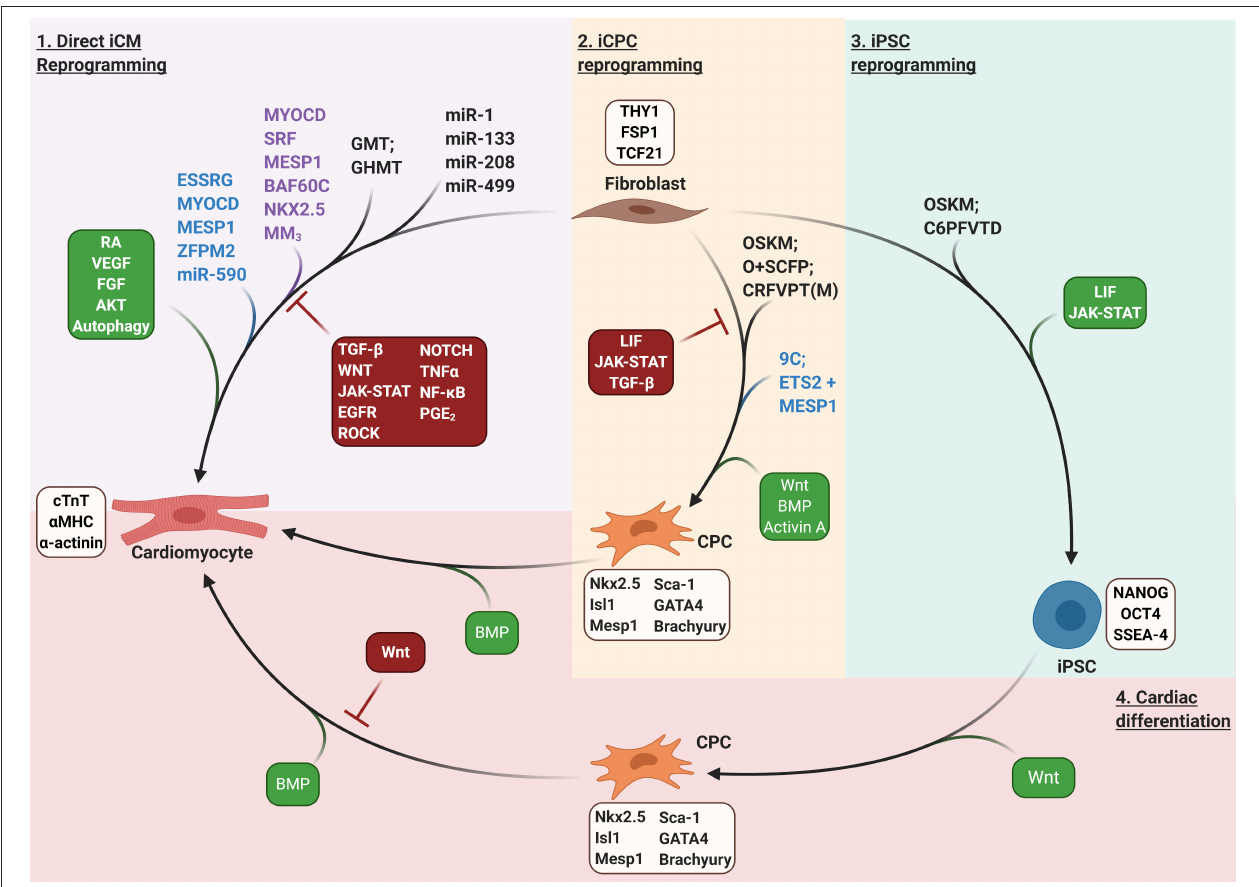
FIGURE 2 | Fibroblast reprogramming strategies. Purple shaded region: direct iCM reprogramming. GMT/GHMT, G ATA4, M EF2C, T BX5/ G ATA4, H AND2, M EF2C, T BX5; MM 3 , MYOD transactivation domain—MEF2C fusion protein. Tan shaded region: iCPC reprogramming; OSKM, O CT4, S OX2, K LF4, C- M YC; O + SCFP, O CT4 + S B431542, C HIR99021, F orskolin, and P arnate; CRFVPT(M), C HIR99021, R epSox, F orskolin, V alproic acid, P arnate, T TNPB, and (Rolipra m ); 9C; CHIR99021, BIX01294, A-83-01, AS8351, SC1, OAC2, Y27632, SU16F, and JNJ10198409. Green shaded region: iPSC reprogramming. C6PFVTD; C HIR99021, 6 16452, P arnate, F orskolin, V alproic Acid, T TNPB, and D Znep. Red shaded region: cardiac differentiation of pluripotent or multipotent stem cells to generate CMs. Lineage specific markers for each cell type are listed in light brown boxes. Purple text indicates factors that enhance reprogramming of rodent fibroblasts. Blue text indicates factors that enhance reprogramming of human fibroblasts. Signaling pathways that enhance or inhibit reprogramming are depicted in green or red boxes, respectively.